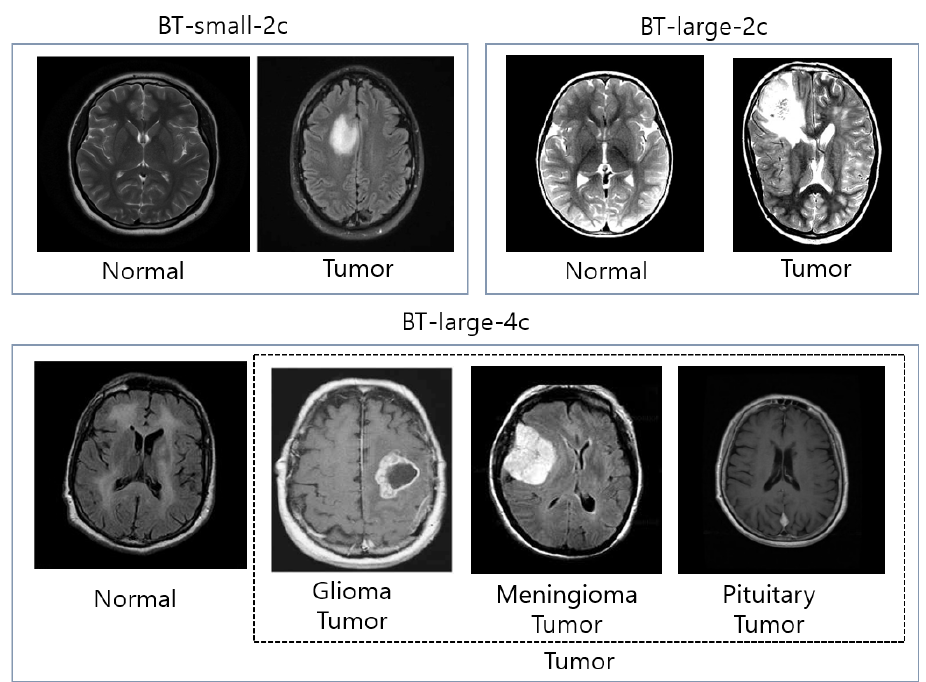
Figure 5. The examples of brain MR images in BT-small-2c, BT-large-2c, and BT-large-4c